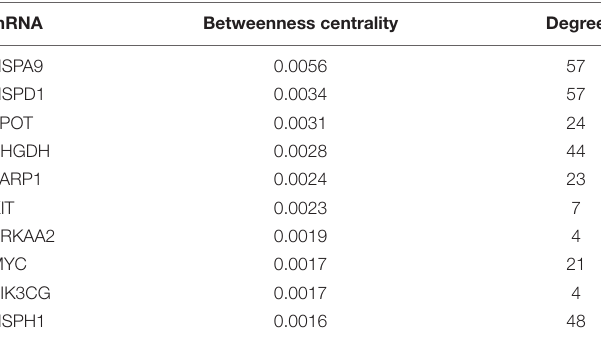
TABLE 3 | Top 10 betweenness centrality mRNAs in the mRNA–mRNA network.